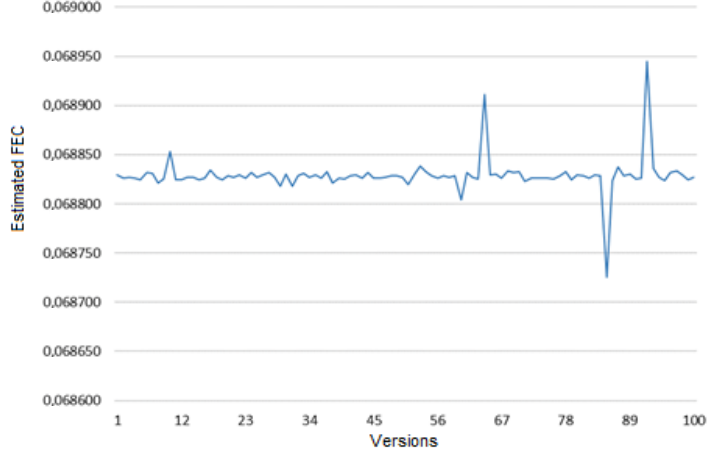
Figure 14. Estimated FEC values per generation.